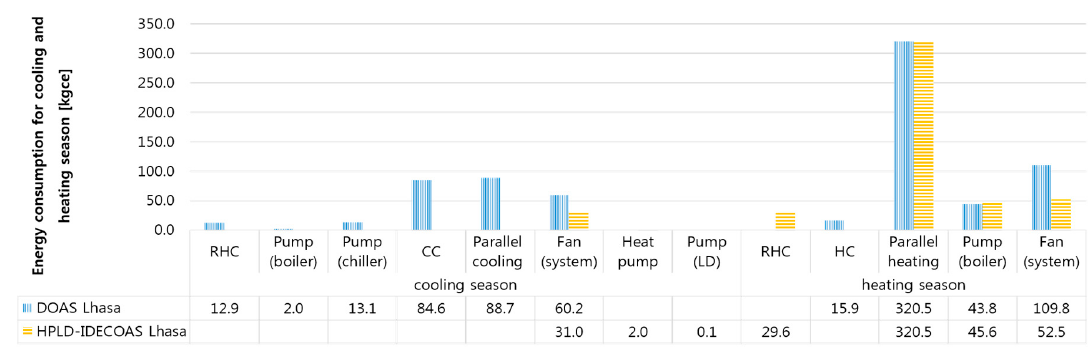
Figure 23. Comparison of seasonal energy consumption in Kashi.